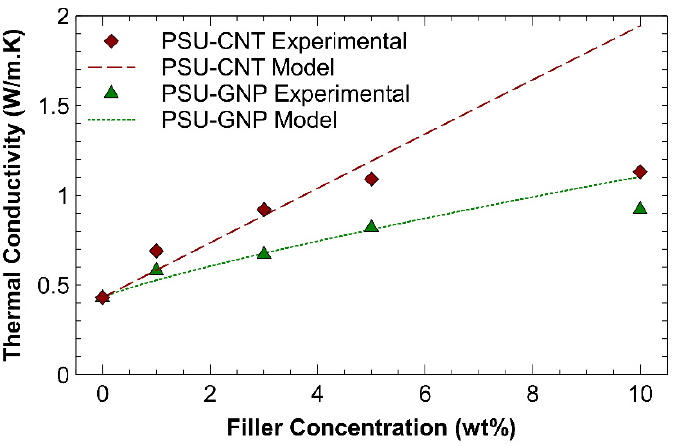
Figure 5. Effect of adding CNTs and GNPs on thermal conductivity of the resultant composites and their correlation with theoretical model.